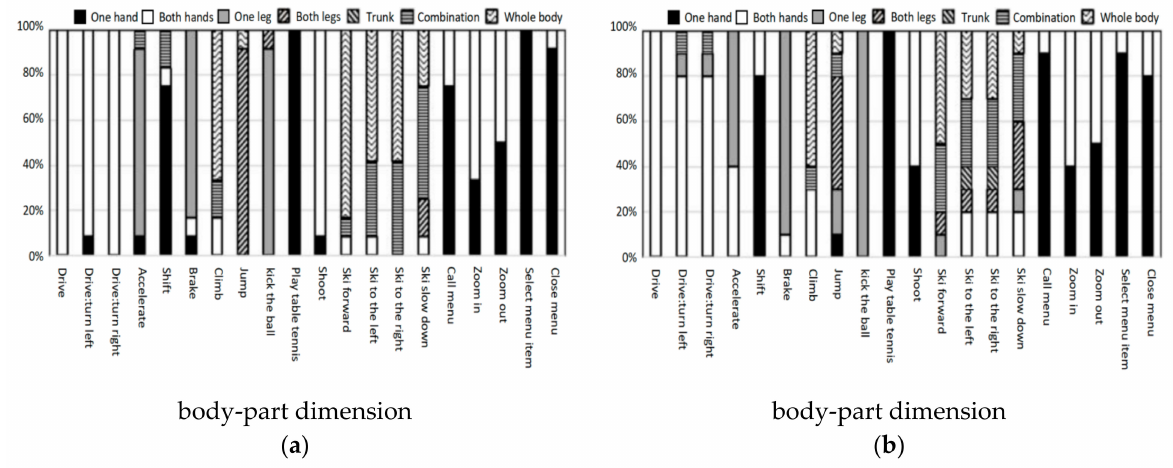
Figure 9. ( a ) Action distribution of young group in the body-part dimension; ( b ) action distribution of elderly group in the body-part